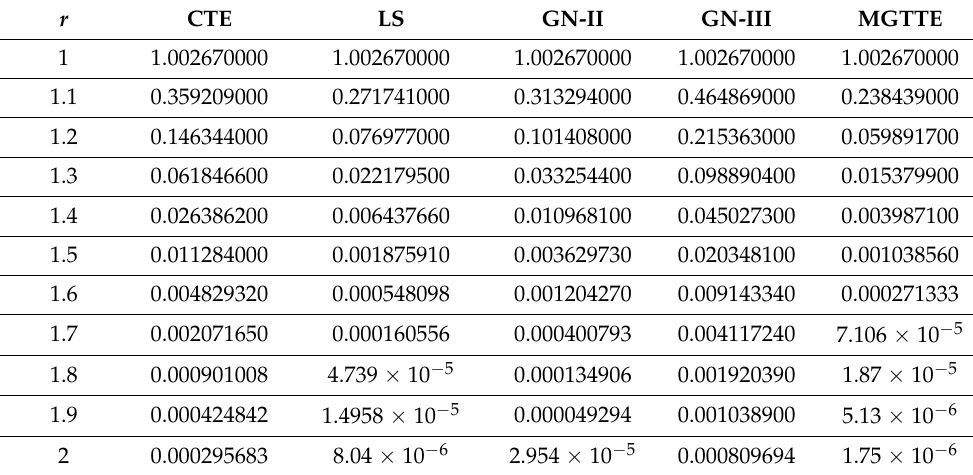
Table 1. The temperature, θ , versus different models of thermoelasticity.